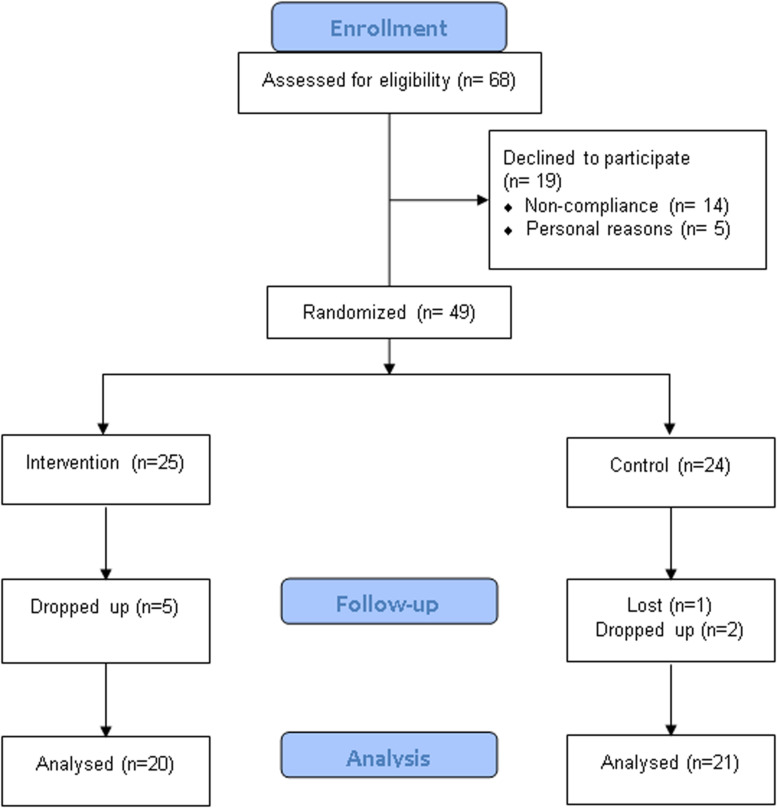
CONSORT diagram.